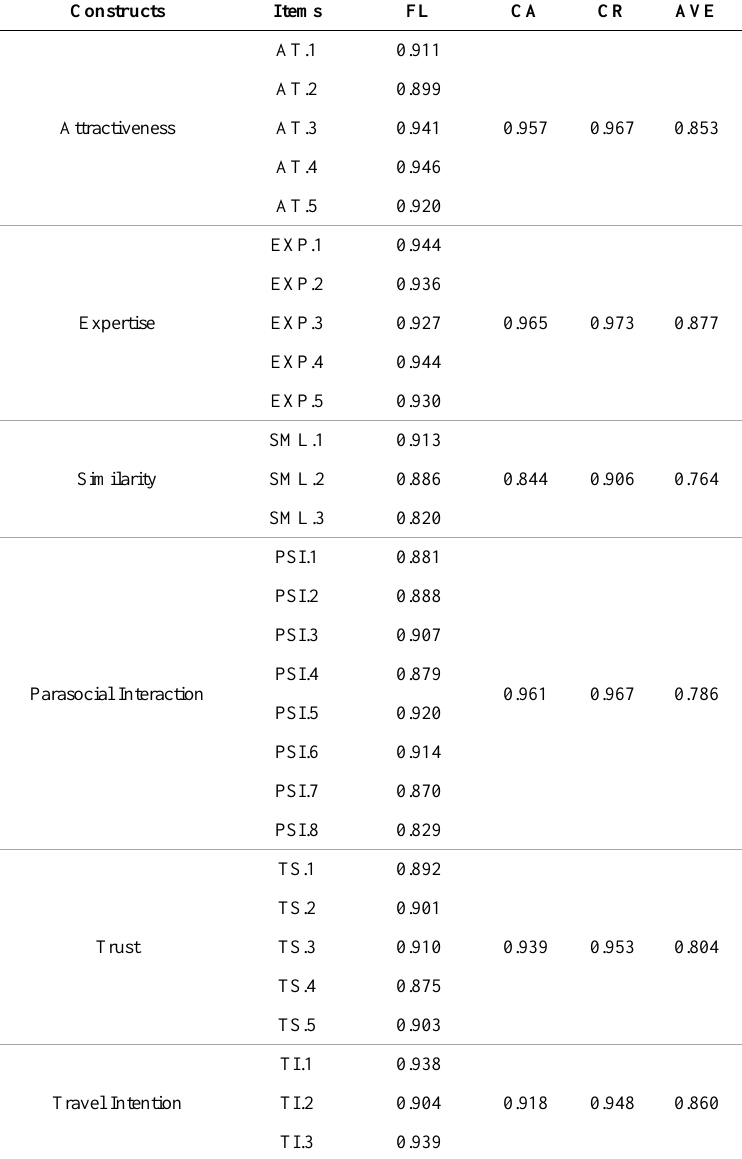
Table 4. The Validity (Construct, Convergent) and Reliability Test